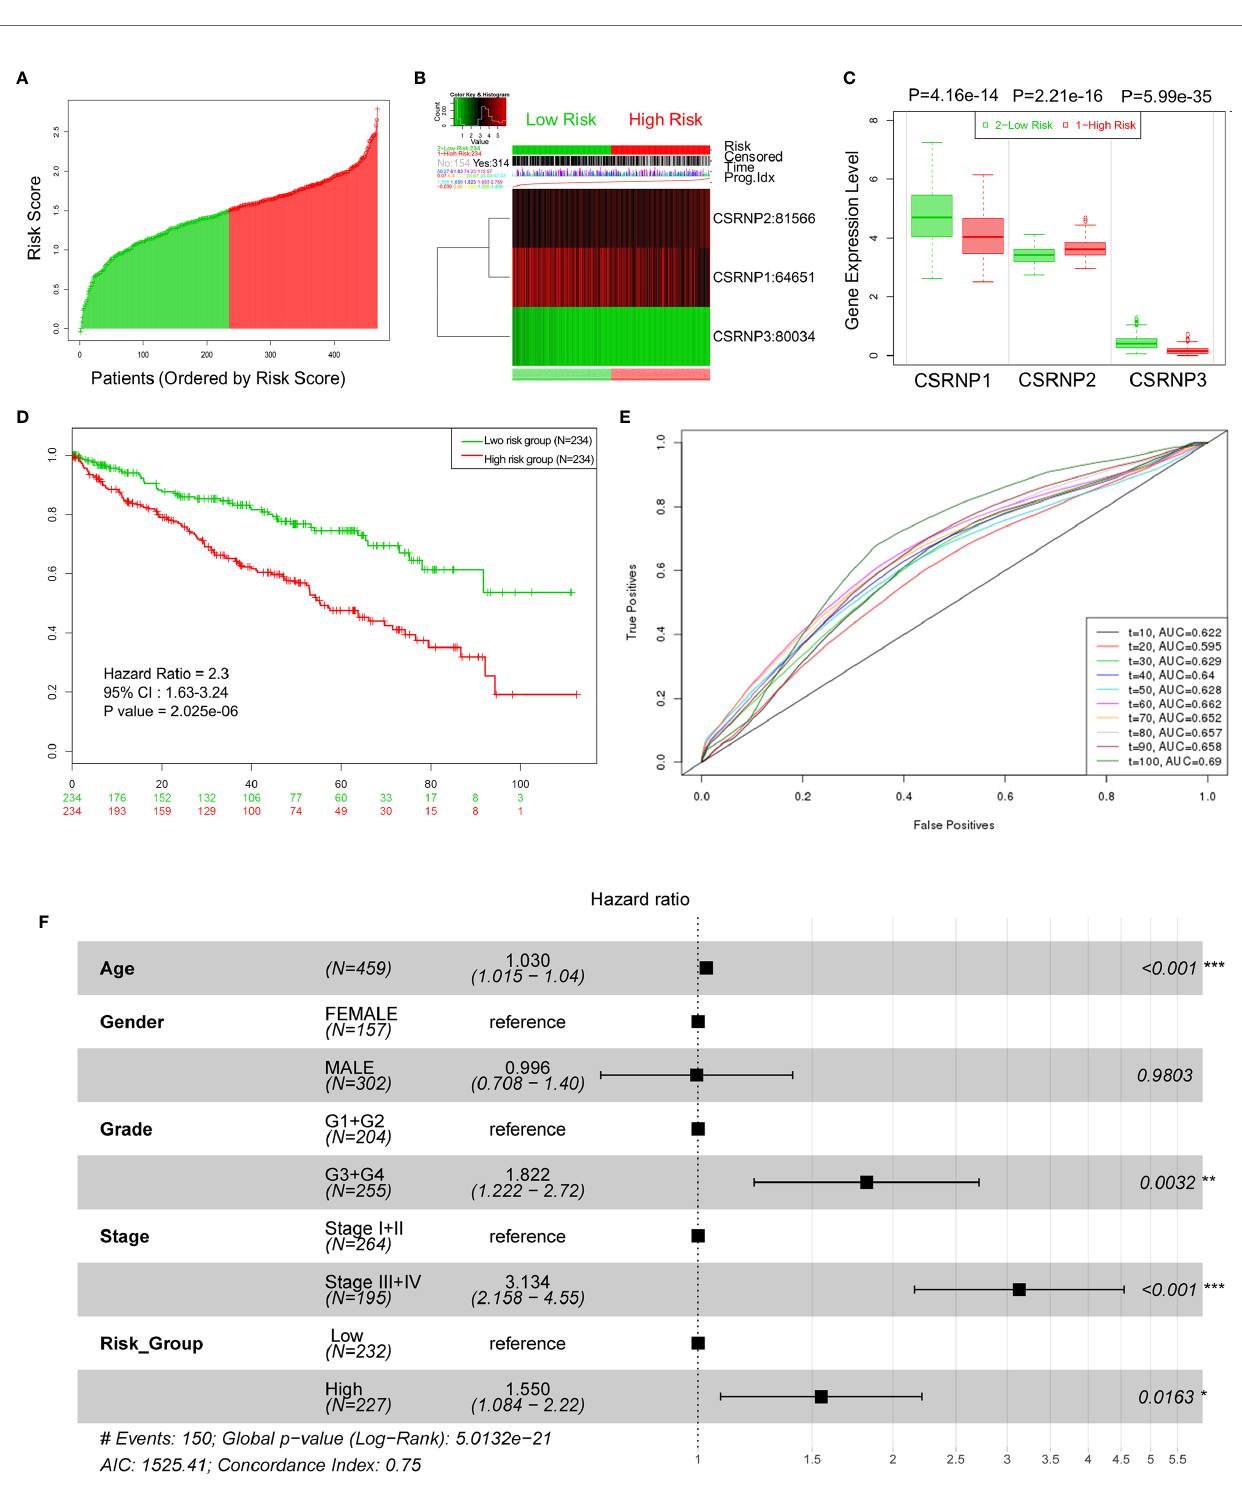
FIGURE 2 | Prognostic values of the CSRNP family signature determined using SurvExpress. (A) Patients were assigned to high- and low-risk groups based on median cutoff risk scores. (B) Heat map of CSRNP family members expression. (C) Comparison of the expression of CSRNP genes between low- and high-risk groups. (D) Survival analysis of low- (green) and high-risk (red) groups. (E) Time-dependent receiver operating characteristics (ROC) curves. (F) Multivariate Cox regression analysis of variables and CSRNP family signature risk scores. * P < 0.05, ** P < 0.01, *** P <